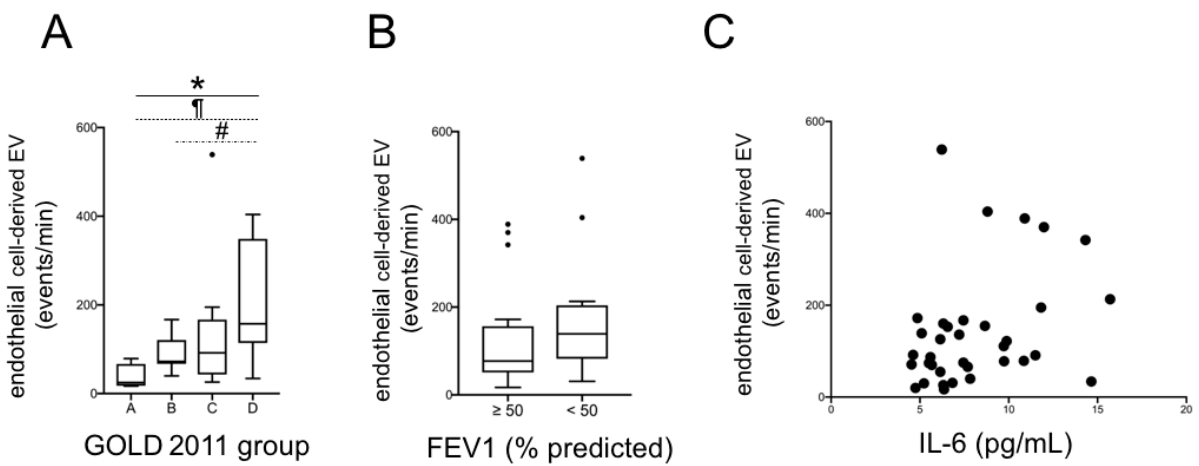
Figure 1. Total EEV according to 2011 GOLD group ( A ) and to FEV1 ( B ) (*: p < 0.001 for trend; ¶ and #: p < 0.05 for group D versus group A and B, respectively; Jonckheere–Terpstra test). Correlation between total EEV and plasma IL-6 ( C ). EEV: endothelial-derived extracellular vesicles; FEV1: Forced Expiratory Volume in the 1st second; IL-6: interleukin-6.